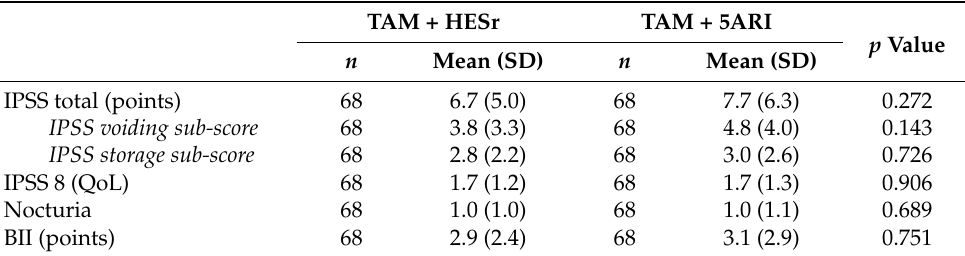
Table 2. Changes from baseline to 6-months in symptoms and quality of life by treatment group (iterative matching